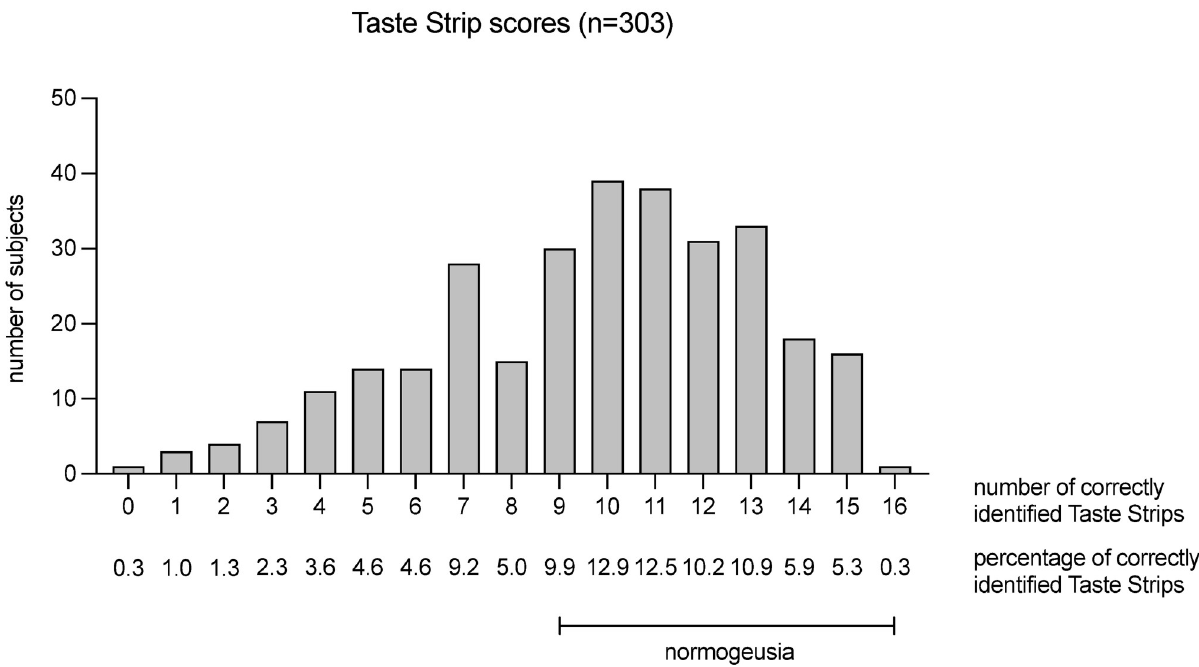
Fig 2. Results of gustatory test. Histogram of the Taste Strips score as number of correctly identified strips, and percentage of the total study population. Normogeusia is defined as nine or more correct answers and hypogeusia as eight and less correct answers [21].